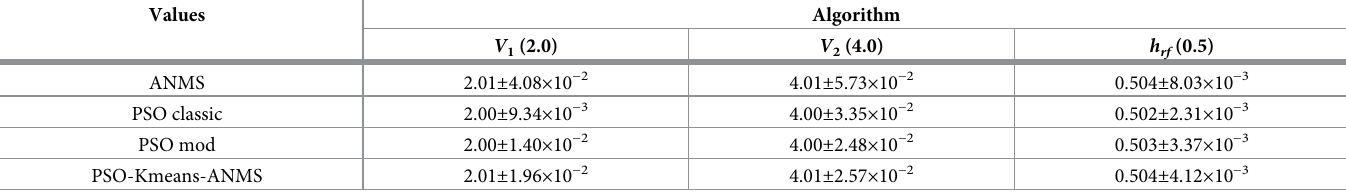
Table 9. Case 1 (100 × 20). Results of the mean value and the respective standard deviation for the parameters of the successful models. Values